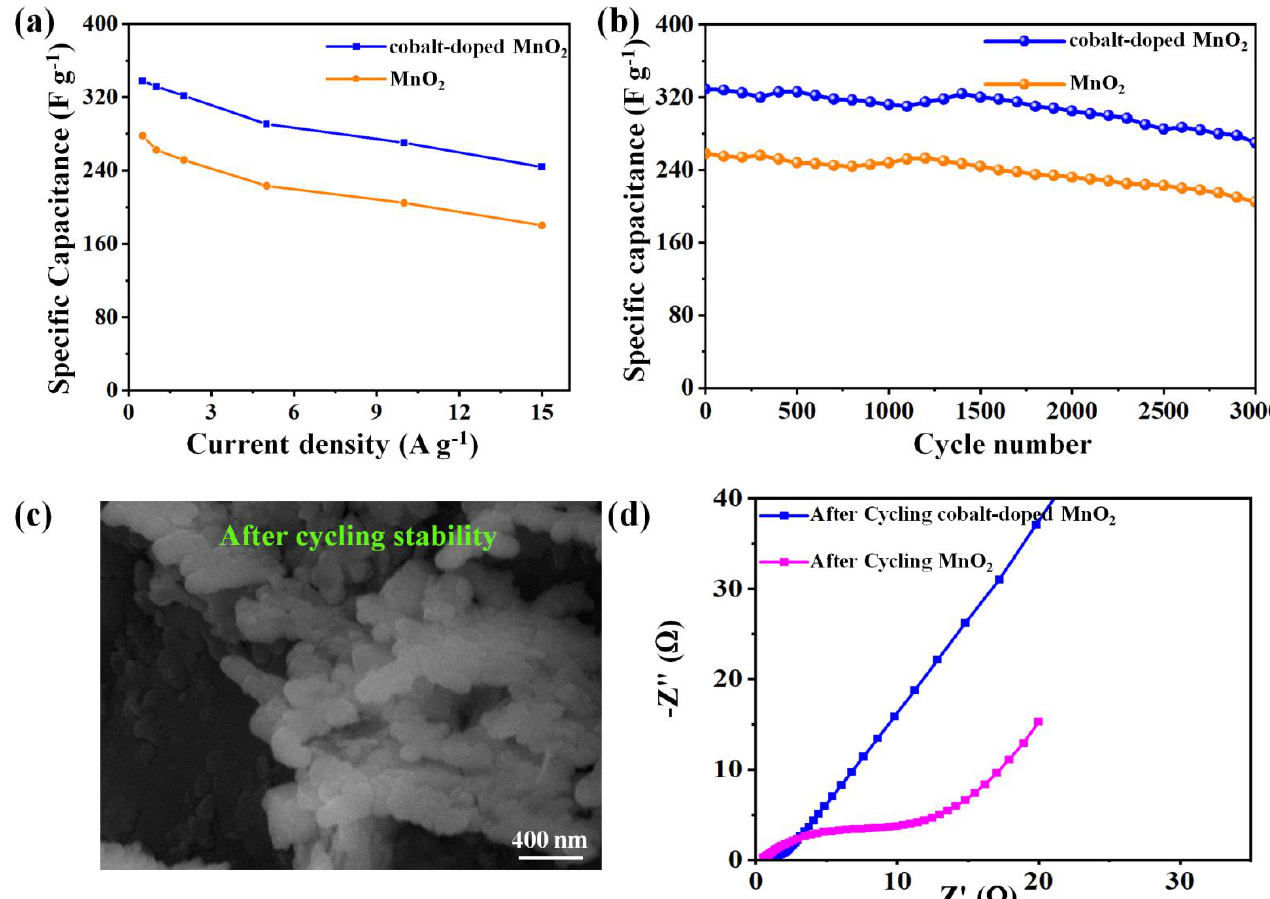
Figure 5. ( a ) Specific capacitances of binary MnO 2 nanoparticles and cobalt-doped@MnO 2 nanosheets composite electrodes; ( b ) charge–discharge cycling stability of binary MnO 2 nanoparticles and cobalt-doped@MnO 2 nanosheets composite electrodes at 2 A g −1 ; ( c ) an SEM image of after 3000 long cycles; and ( d ) an Nyquist plot of after 3000 GCD cycles of binary MnO 2 nanoparticles and cobalt-doped@MnO 2 nanosheets composite electrodes. Table 1. MnO 2 composite electrode performance comparison over the last five years.